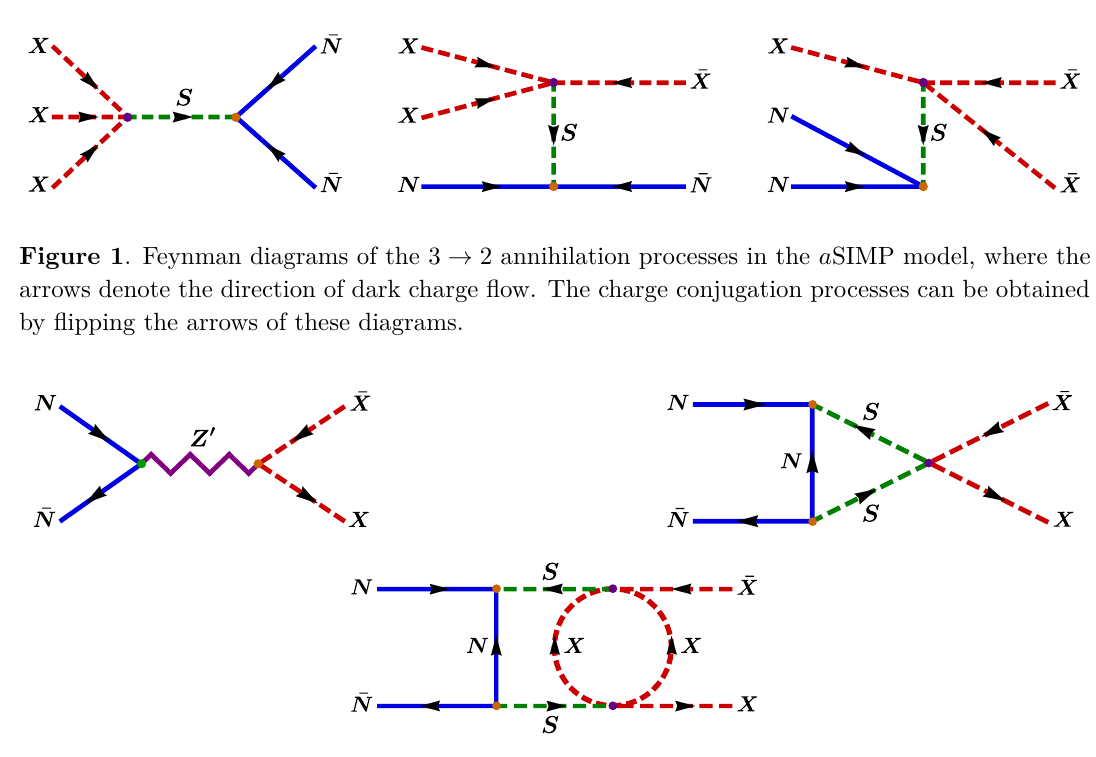
Figure 2 . Tree-level, one-loop, and two-loop Feynman diagrams for the 2 → 2 annihilation processes in the a SIMP model, where the Feynman diagrams for the inverse processes X ¯ X → N ¯ N can be obtained by reversing the above